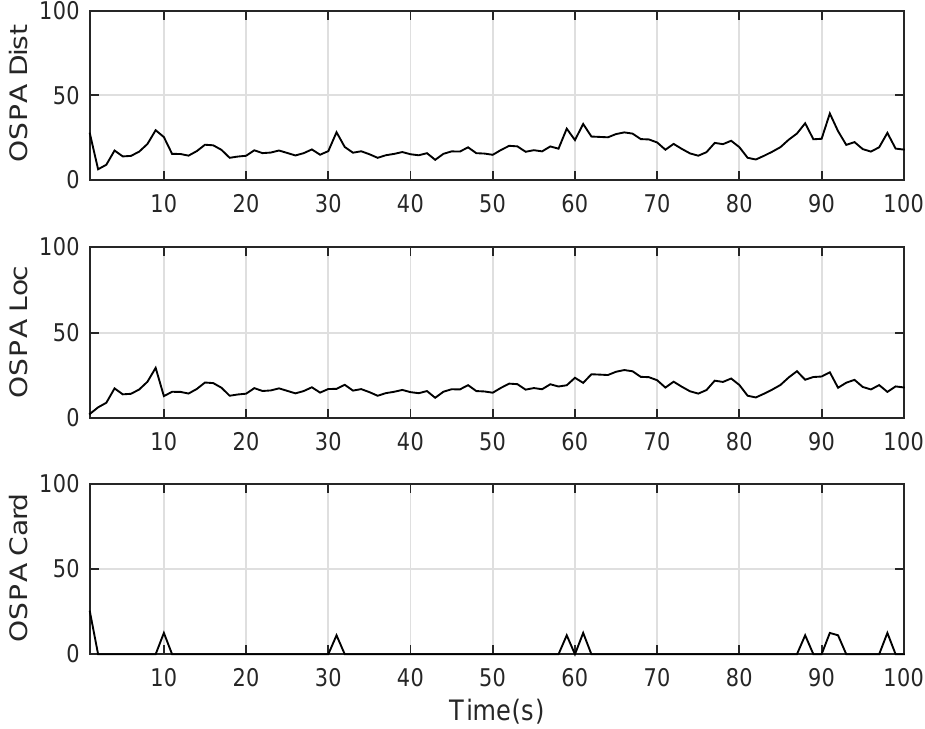
Figure 16. The OSPA distance by Gibbs GLMB filter for experiment